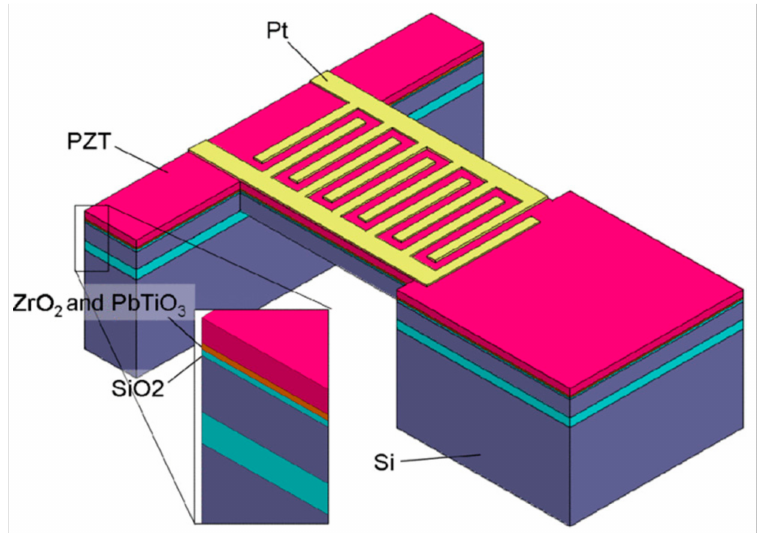
Figure 8. Schematic drawing of the proposed piezoelectric MEMS energy harvester operating in the d33 mode for the purpose of scavenging low vibrations